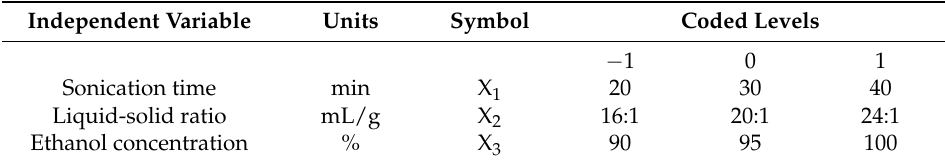
Table 6. Independent variables and the coded and actual values used for optimization. Independent